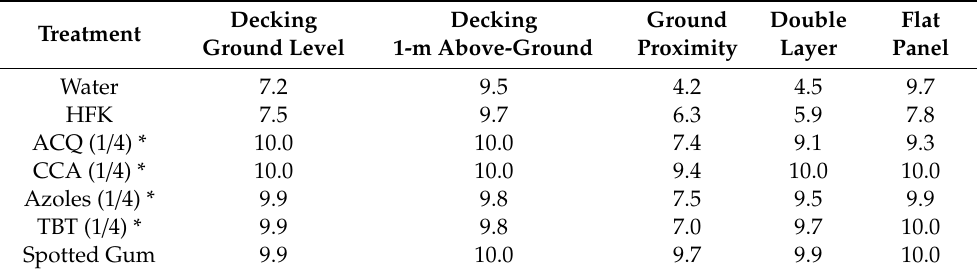
Table 1. Decay Ratings after 4 years exposure at Whakarewarewa,